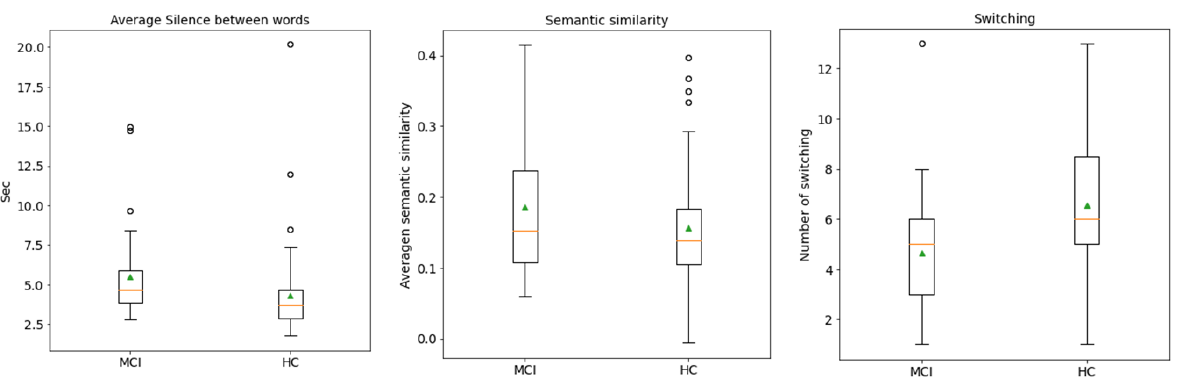
Figure 9. Distribution of the feature values between MCI and HC. Green triangles represent the data means. The orange lines show the medians of the data. White circles are the data outliers. MCI, mild cognitive impairment; HC, healthy control.